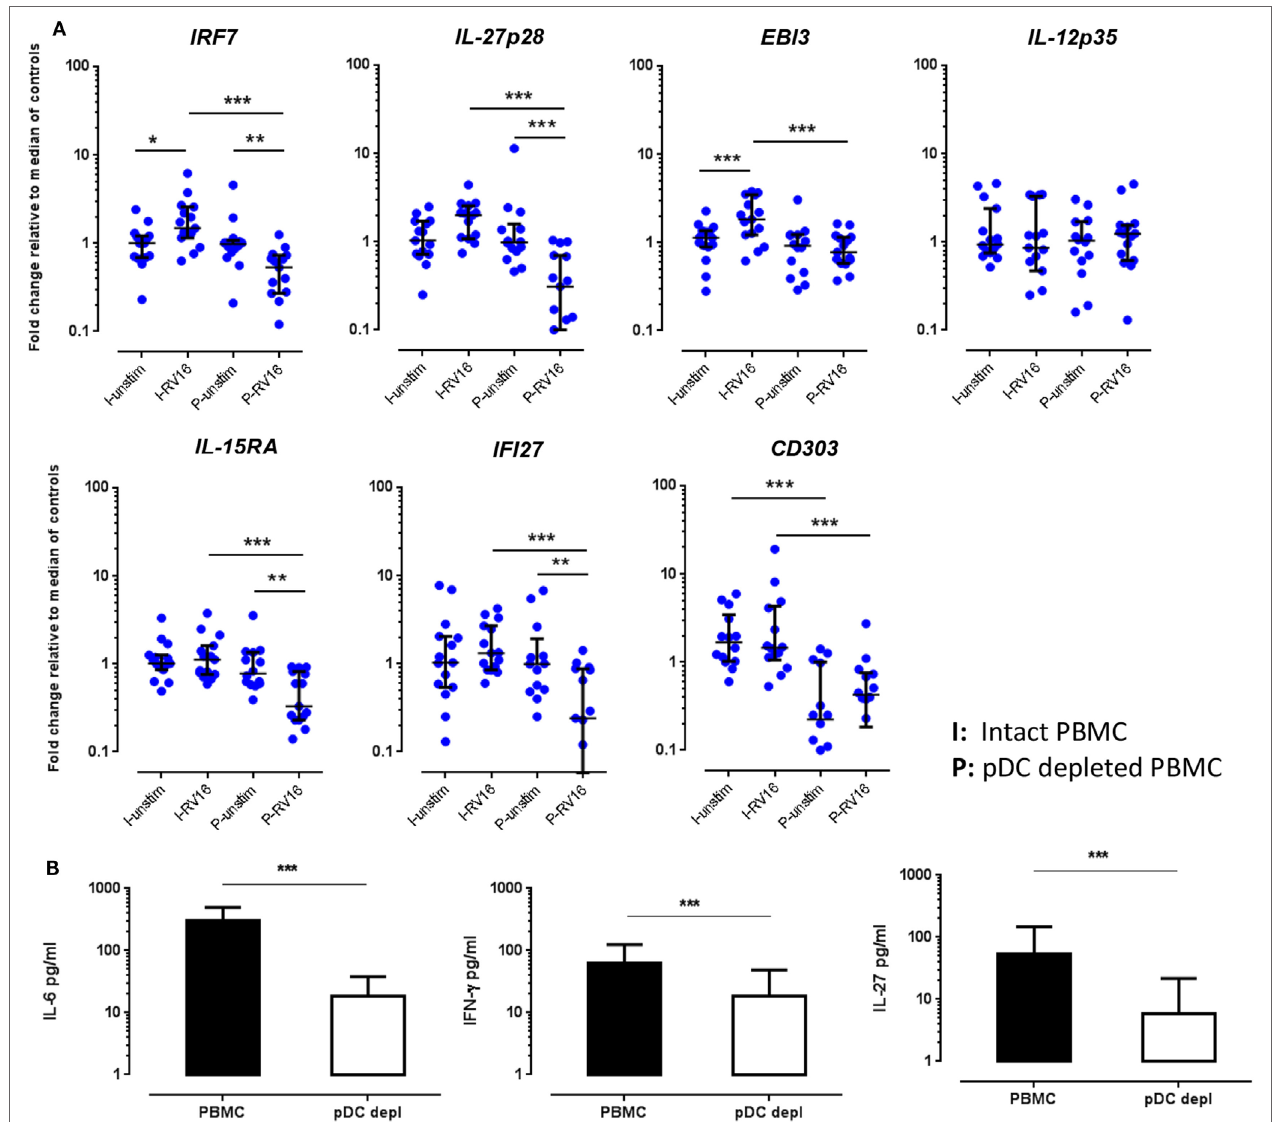
FigUre 5 | Validations experiments using real-time PCR (RT-PCR) and enzyme-linked immunosorbent assay (ELISA). Peripheral blood mononuclear cell (PBMC) and plasmacytoid dendritic cell (pDC)-depleted PBMC ( n = 15) were cultured for 24 h in the absence or presence of human rhinoviruses strain 16 (RV16). mRNA expression of IRF7 , IL-27p28 , EBI3 , IL-12p35, IL-15RA , IFI27 , and CD303 was determined by RT-PCR. Data represent fold change relative to median of controls against the average of two reference genes ( UBE2D2 and B2M ) (a) . IL-6 and interferon (IFN)- γ were measured in culture supernatant by ELISA. Net cytokine values are shown (RV16-stimulated cultures minus the unstimulated cultures) (B) . All data represent mean ± SD. *p < 0.05, ** p < 0.01, *** p < 0.001 (I, intact PBMC; P, pDC-depleted